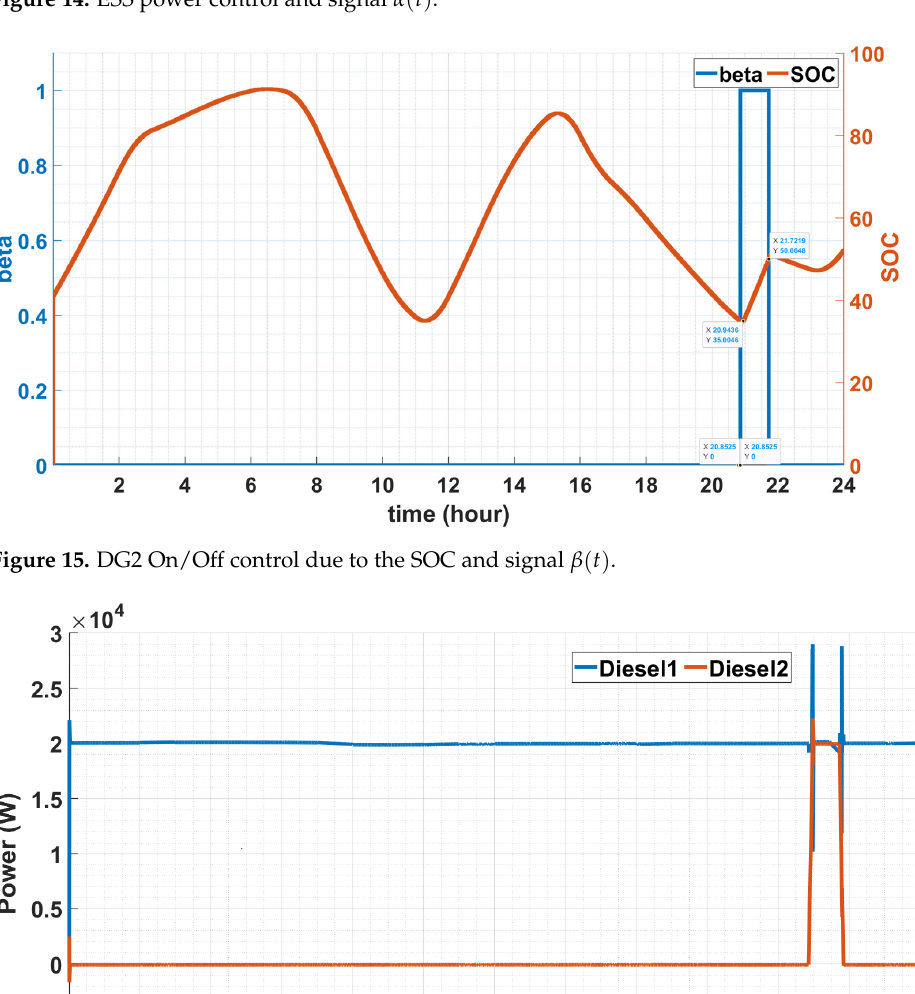
Figure 14. ESS power control and signal 𝛼(𝑡) .